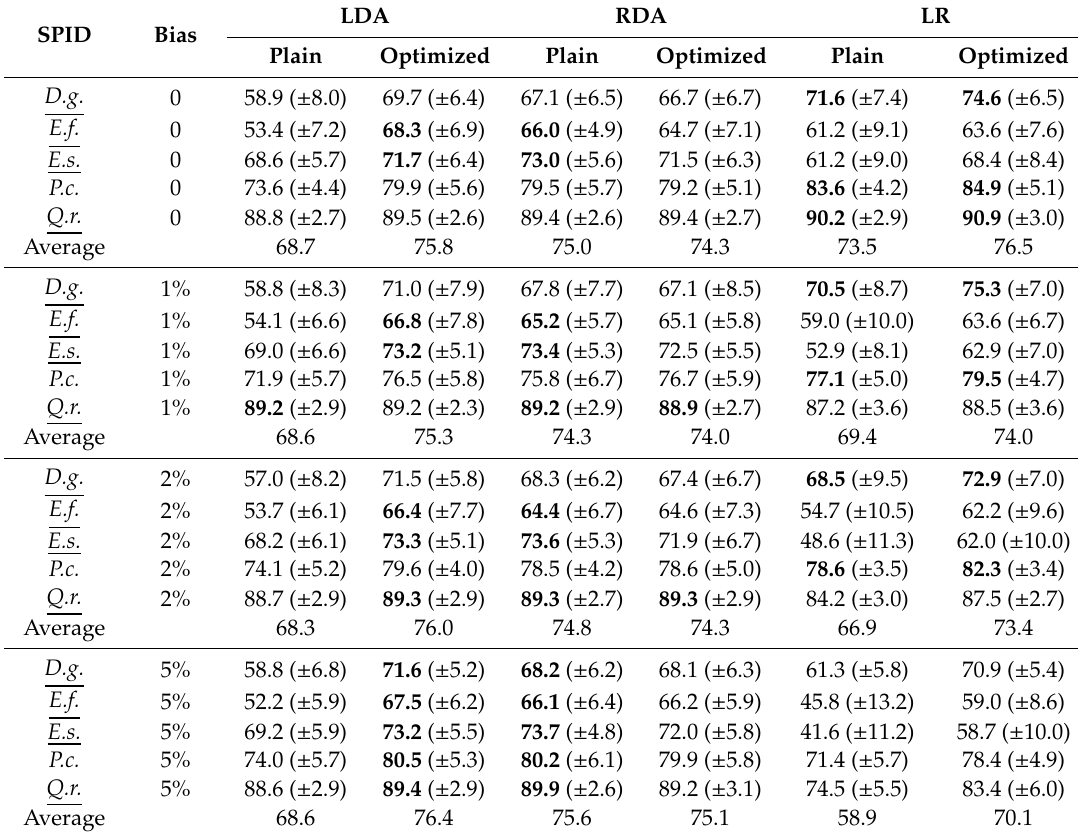
Table A3. Comparison of classification methods with and without bias. Plain and optimized indicate whether an optimization step (selecting a threshold probability value) was applied or not. This step aims at maximizing either the F measure (0% contamination) or the Lee and Liu 2003 criterion (1% contamination). F-measure is given at object level. The best predictions for each species, configuration and method are in